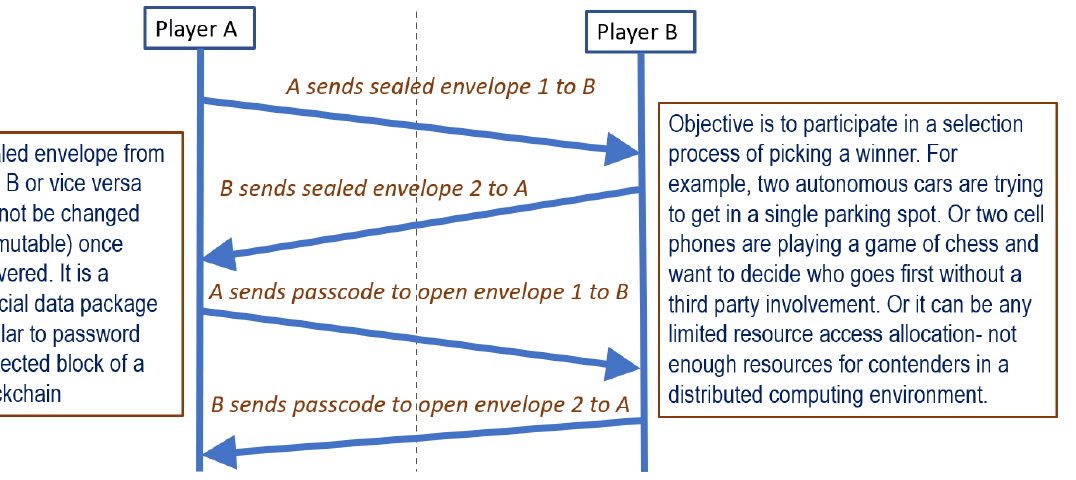
Figure 2. Cross chain communication using sealed envelope.